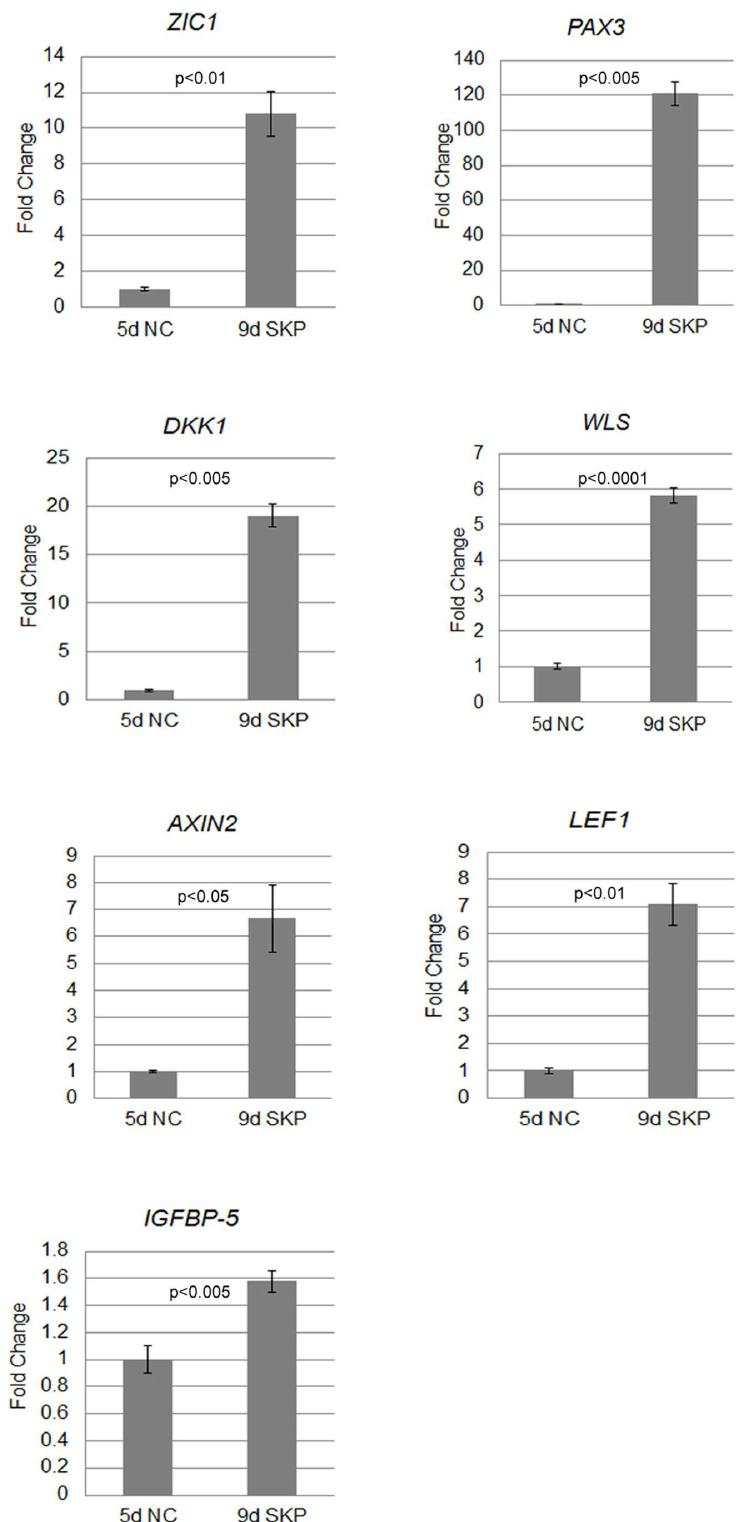
Fig 3. Gene expression analysis during hiPSC-SKPs differentiation. Quantitative real time PCR results showingchangesbetweenNC and iPSC-SKPs.